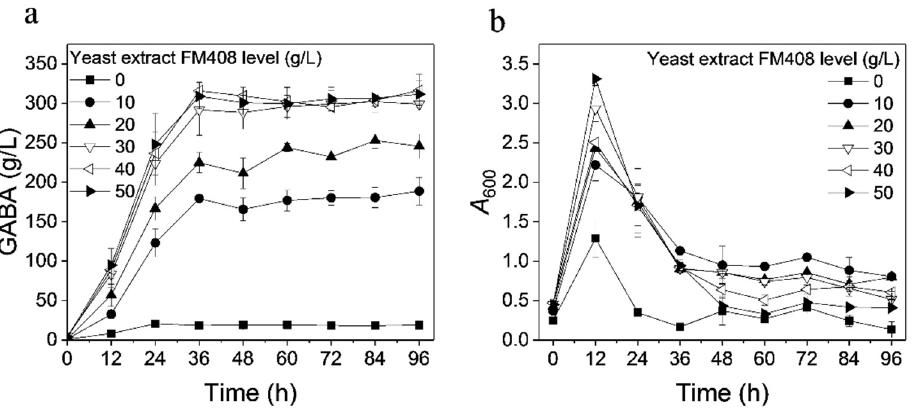
Figure 2. The effect of yeast extract FM408 on ( a ) GABA production and ( b ) cell growth. This was evaluated using a 250 mL Erlenmeyer fermentation flask at 32.0 °C. Cell growth was expressed as A 600 . Vertical bars represent standard deviations of means ( n = 3). The difference in 48 h GABA concentrations was not significant between 40 g/L and 50 ( p = 0.979) or 30 g/L of yeast extract FM408 ( p = 0.573), but it was significant between 40 g/L and 20 ( p = 0.000) or 0 g/L of yeast extract FM408 ( p = 0.000). GABA, gamma-aminobutyric acid; A 600 , absorbance at 600 nm.